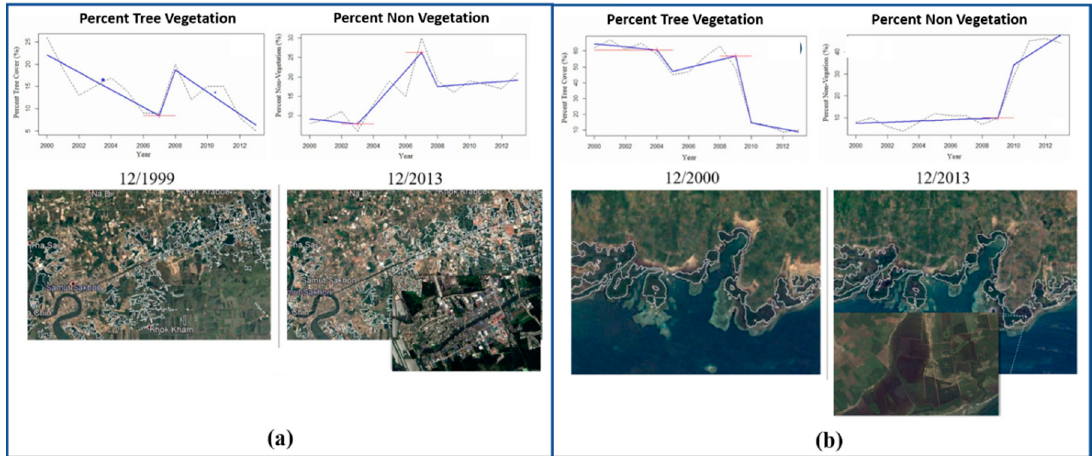
Figure 16. ( a ) Mangrove deforestation driven by infrastructure expansion in Samut Sakhon State, Thailand; ( b ) mangrove deforestation driven by aquaculture expansion in Northern Sulawesi,